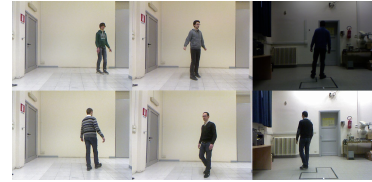
Figure 6. Market -1501 dataset exemplary samples.